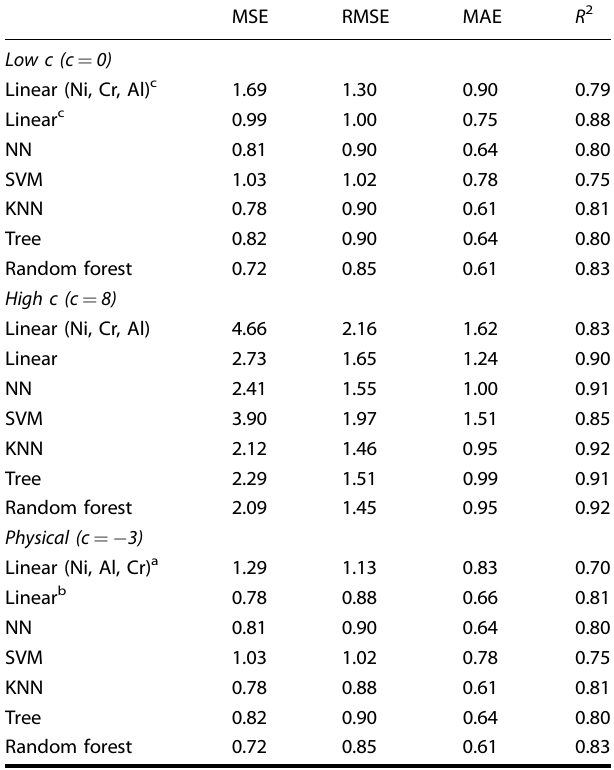
Table 1. Mean-squared error (MSE), root mean-squared error (RMSE), mean absolute error (MAE) and R 2 coef fi cient for the various machine learning approaches used to fi t the Arrhenius slope for the parabolic rate constant as a function of materials